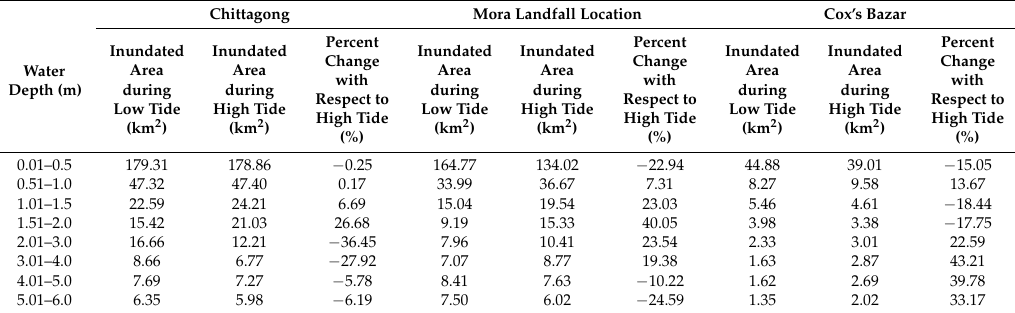
Table 1. Calculation of inundated area during low and high tide based on surge depth. Water Depth (m)